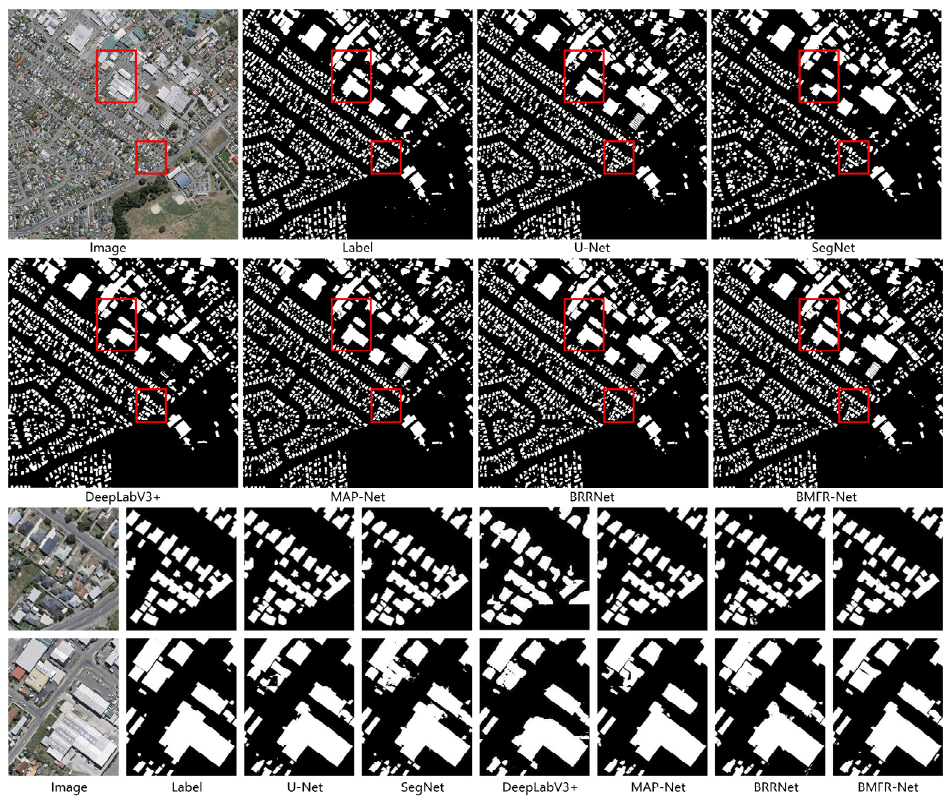
Figure 9. Extensive area building extraction results by different methods on the WHU Buildings Dataset. The bottom column represents the corresponding partial details.